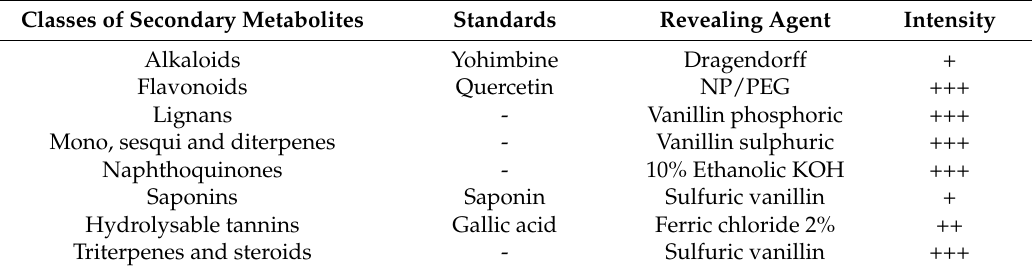
Table 1. Metabolic compounds identified in the phytochemical characterization of X. americana (XaAE) aqueous